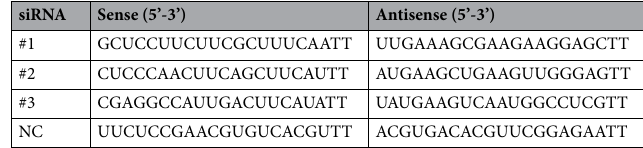
RNA isolation and real‑time PCR. Total RNA was extracted from THP-1 cells using the Total RNA Extraction Kit (TIANGEN, China) following the manufacturer’s protocol. The first strand was synthesized from 1 μg of total RNA using the Reverse Transcription System Kit (Takara, China) and RT-qPCR was performed using SYBR Premix ExTaq II (Takara, China) in a total volume of 20 μL. Sequences of primers using in RT-qPCR are listed in Table 2. Expression levels are normalized to GAPDH, with each assay performed in triplicate. Rela- tive fold changes in messenger RNA expression were calculated using the 2 -ΔΔCt method. Western Blotting. Total protein was extracted from THP-1 cells using a total protein extraction kit (Key- GEN BioTECH, China), following which cell lysate was spun at 12,000 rpm. The supernatant was then col- lected and protein concentration was determined via BCA assay (ThermoFisher, USA). The protein samples were then heated at 100 ℃ in 1 × protein loading buffer (Transgene, China) for 5 min and separated via 10% SDS-PAGE. Blots were then wet transferred to PVDF membranes, blocked with 5% skimmed milk for 1 h at room temperature and phosphorylated antibodies were blocked with 3% BSA. Samples were then incubated